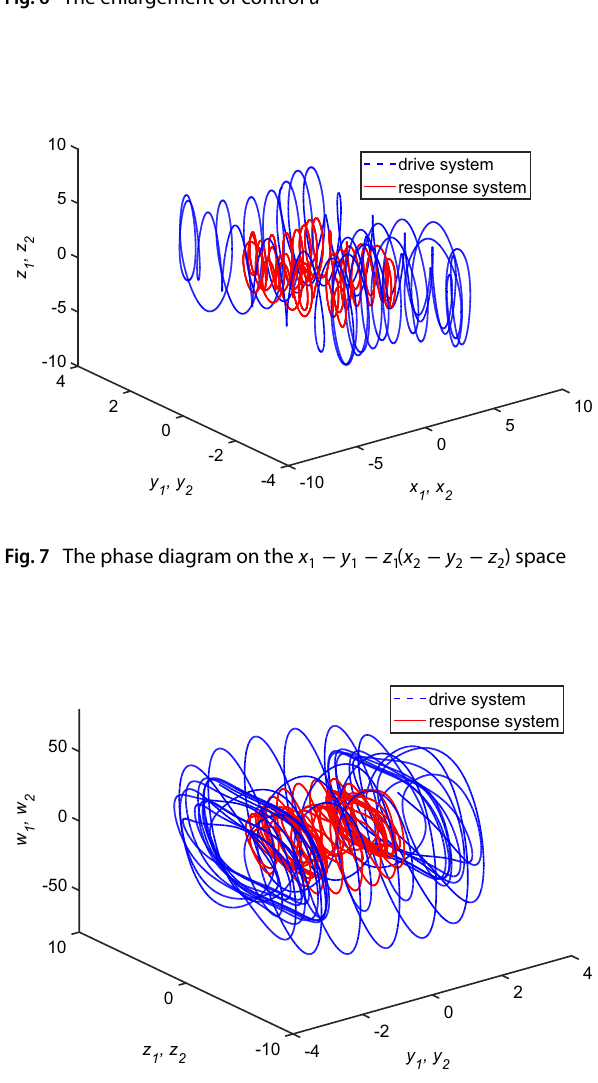
Fig. 8 The phase diagram on the y 1 − z 1 − w 1 ( y 2 − z 2 − w 2 ) space